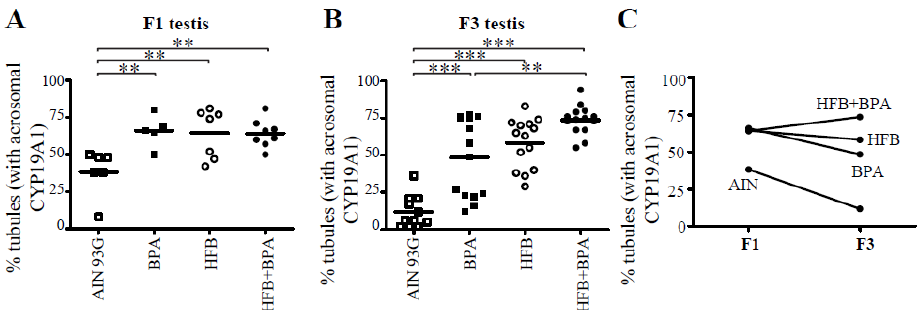
% STs with acrosomal CYP19A1 in round Spermatid Figure 4. Increased expression of acrosomal CYP19A1 in round spermatids of F1 and F3 T + E2 − treated HFB and HFB + BPA groups. ( A ) F1 and ( B ) F3 testes were scored for number of STs with acroso- mal CYP19A1 in round spermatids. Each symbol represents a pup from an independent litter. ( C ) Comparison of F1 and F3 CYP19A1 expressing tubules. ** p < 0.01, *** p < 0.001 using one-way ANOVA between groups indicated, followed by Dunnett’s multiple comparison